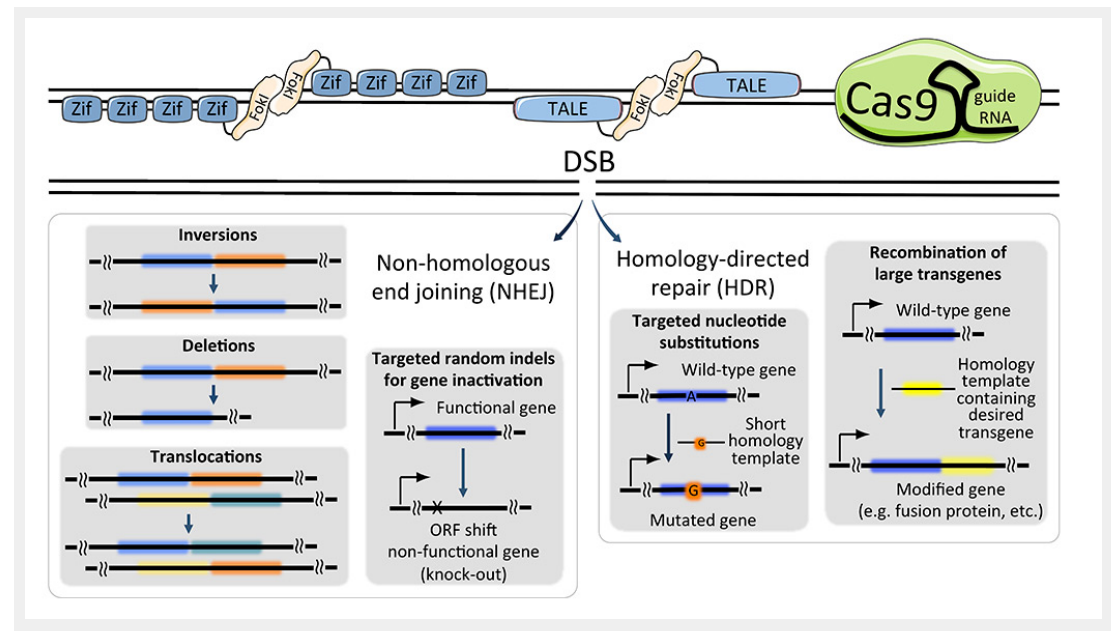
Figure 2 Comparisons of programmable nucleases and possible outcomes. Zinc finger nucleases (top left), transcription activator-like effector nucleases (TALENs; top middle) and CRIPSR/Cas9 (top right) systems introduce a site-directed double strand break (DSB) in DNA. Depending on the repair mechanism, nonhomologous end joining (NHEJ) or homology-directed repair (HDR), the site of interest can be left with random mutations, designed mutations, insertion of large transgenes, or (in case more than one DSB is generated), inversions, deletions and translocations. Cas9 = CRISPR-associated system nuclease 9; CRISPR = clustered regularly interspaced short palindromic repeats; Fokl = Fokl nuclease; ORF = open reading frame; TALE = transcription activator-like effector; Zif = zinc finger